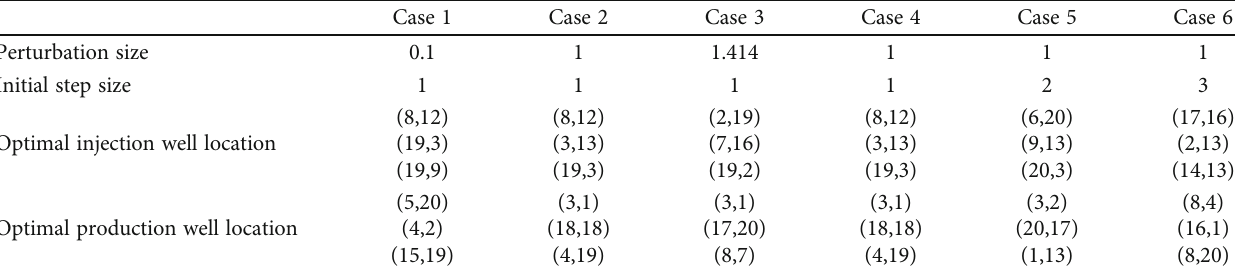
Figure 16: The log-permeability distribution in the horizontal direction for ten realizations. Table 4: Result of optimal well